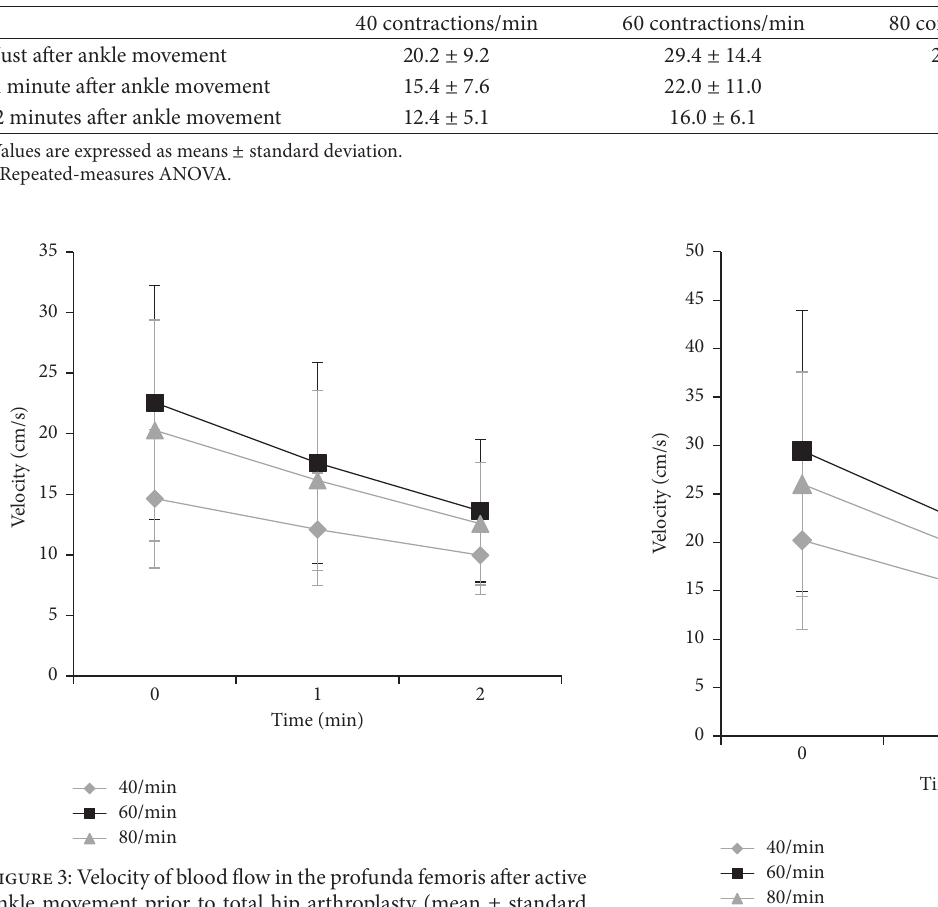
Just after ankle movement